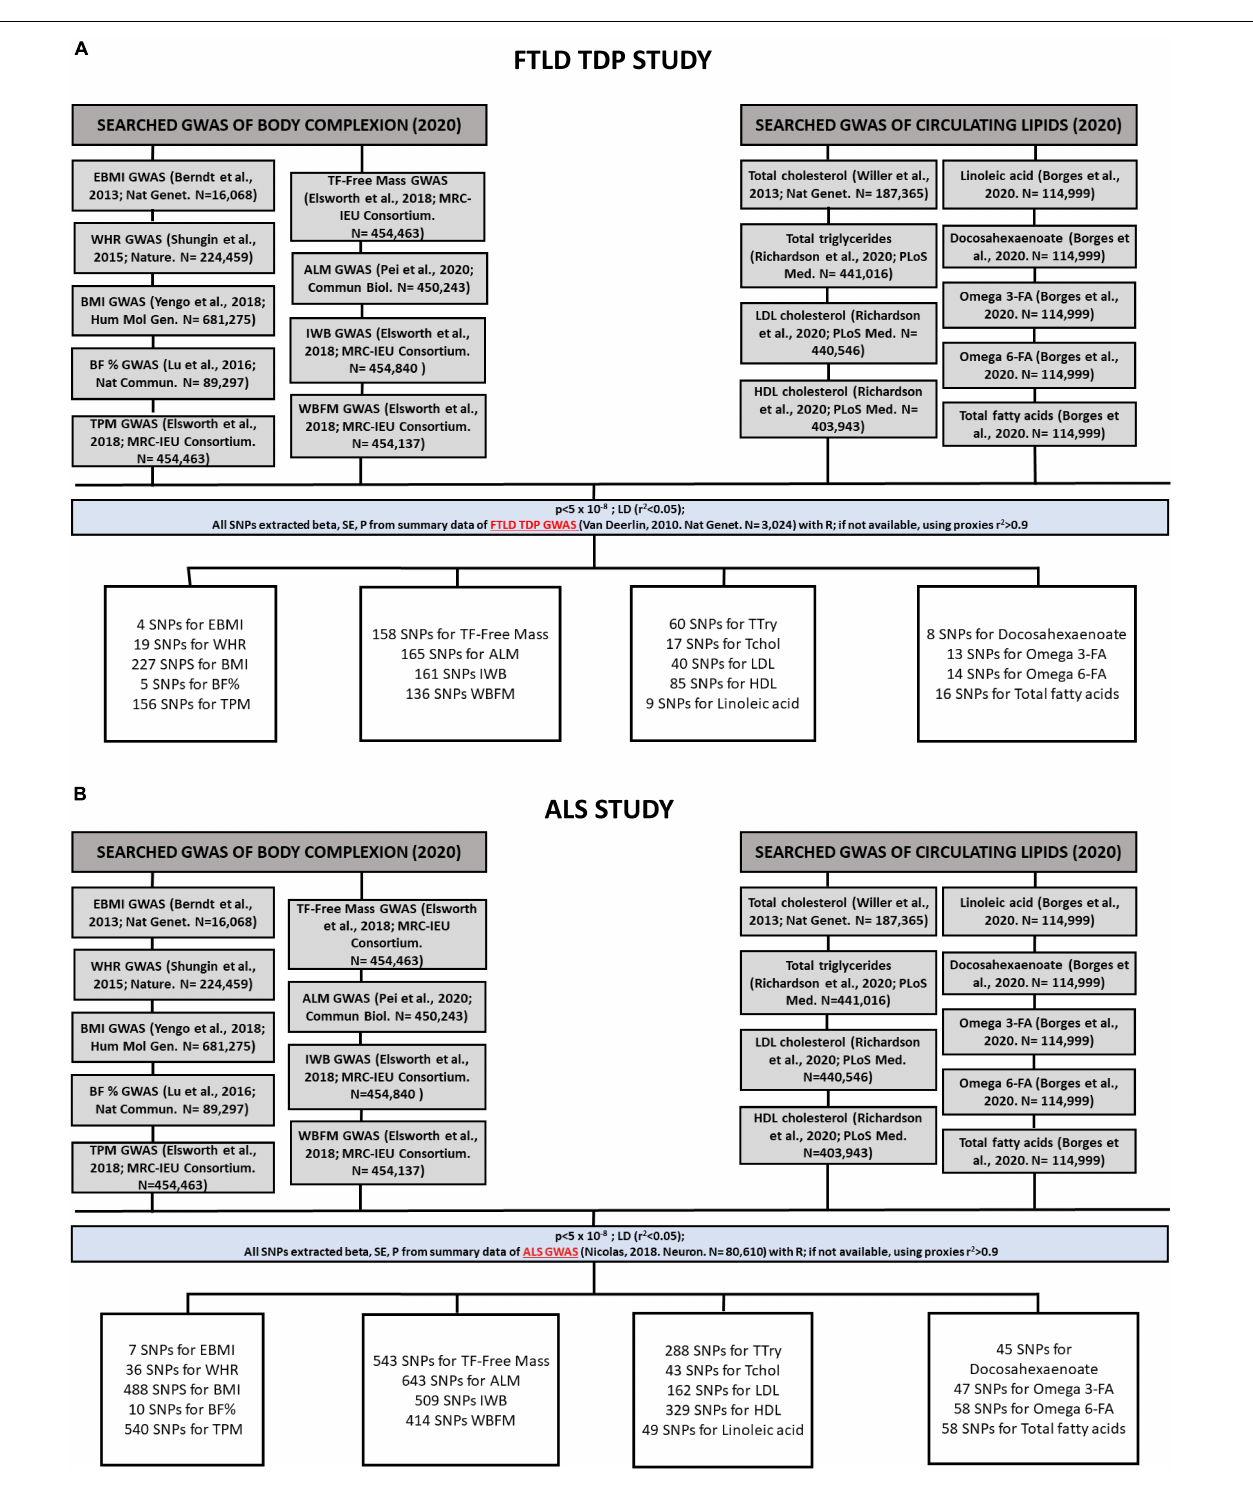
FIGURE 2 | Flowchart followed by the process of identification and selection of genome-wide association studies (GWAS) and the SNPs used as instrumental variables (IVs) that have been included in the Mendelian randomization analyses of FTLD TDP subtype (A) and ALS (B) . In the body complexion group we included 9 traits: “Extreme body mass index,” “body mass index” (BMI), “waist-to-hip ratio” (WHR), “body fat percentage” (BF%), “trunk predicted mass,” “trunk fat-free mass,” “appendicular lean mass,” “impedance whole body,” “whole body fat mass.” In the circulating lipids group we included 9 traits: “Total triglycerides” (TG), “total cholesterol”(TC), “LDL cholesterol” (LDL), “HDL cholesterol” (HDL), “linoleic acid,” “docosahexaenoate” (DHA), “omega 3-fatty acid,” “omega 6-fatty acid,” and “total fatty acids.”